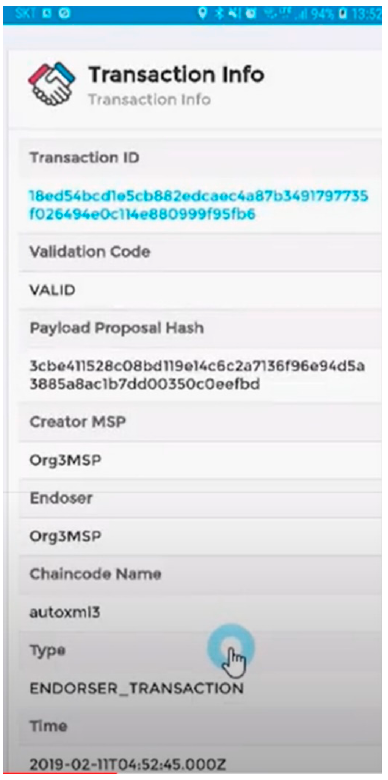
Figure 15. Legacy inheritance smart contract storage screen. Figure 16 is the screen of block coding. Electronics 2020 , 9 , x FOR PEER REVIEW